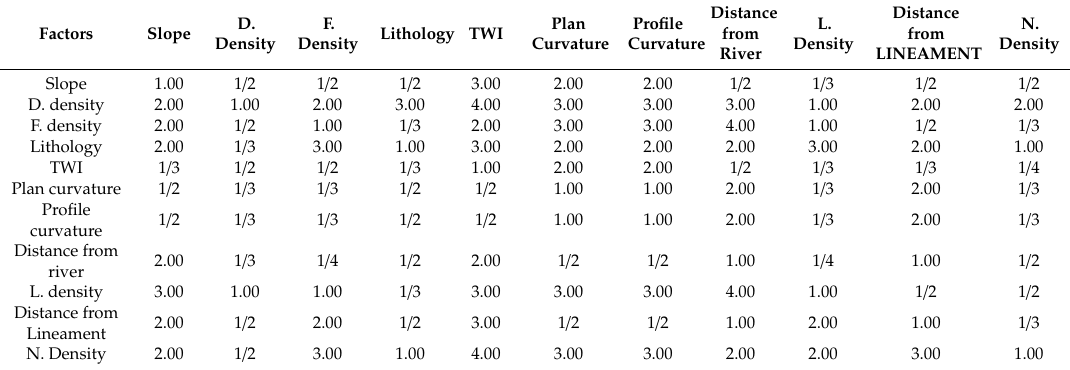
Table 3. Pairwise comparison matrix of 11 groundwater prospecting factors for the analytical hierarchy process (AHP).